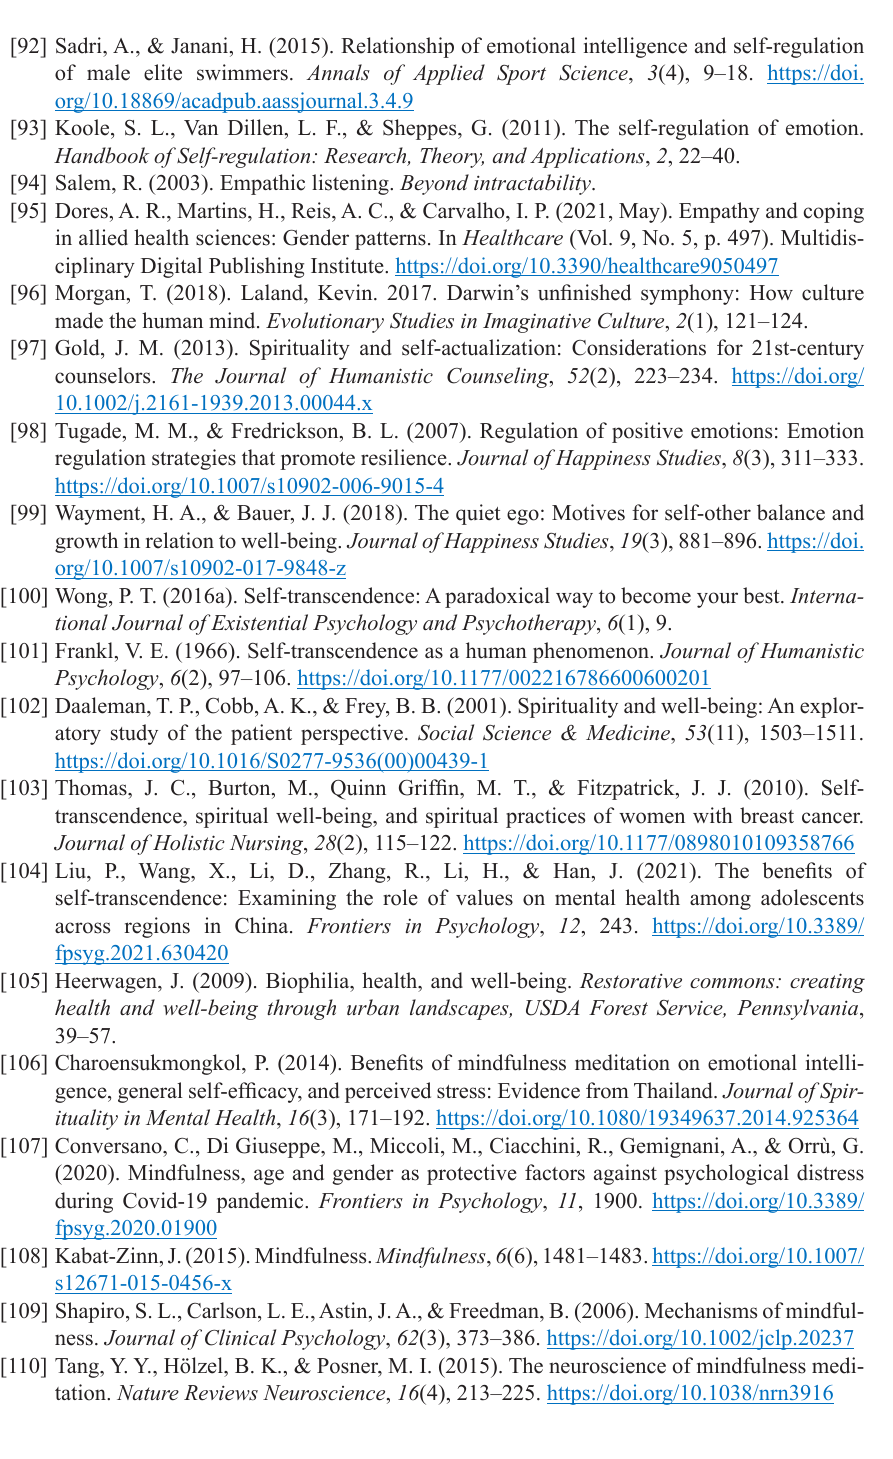
Paper —Metacognitive and Metaemotional Training Strategies through the Nine-layer Pyramid